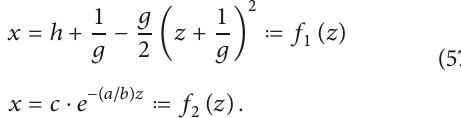
where Γ − 𝑀 and Σ − 𝑔 are given by (52) and (54), respectively (Figure